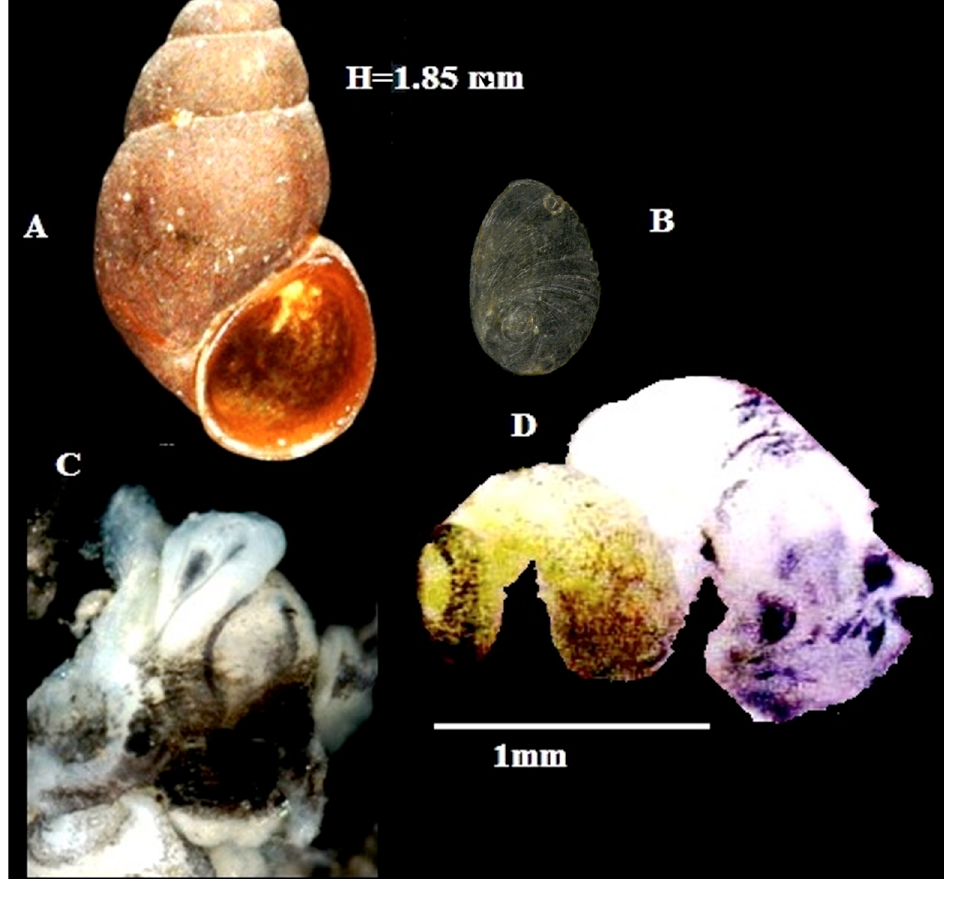
Fig. 3. Bullaregia tunisiensis gen. et sp. nov. A . Shell (holotype). B . Operculum. C . Head and penis. D . Coiled